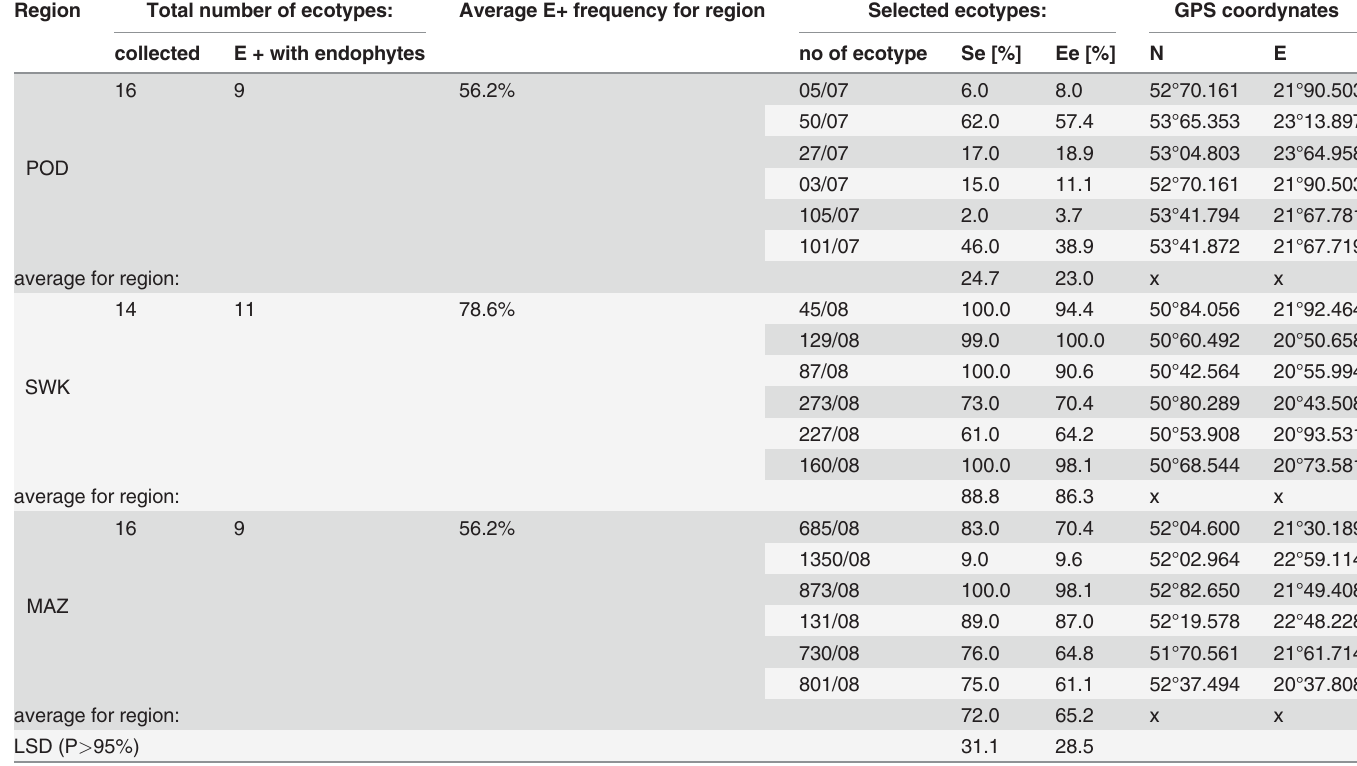
Table 1. Mean endophyte infection (%) of perennial ryegrass ecotypes originating from Podlaskie (POD), Ś wi ę tokrzyskie (SWK) and Mazowieckie (MAZ) regions in Poland. Region Total number of ecotypes: Average E+ frequency for region Selected ecotypes: GPS